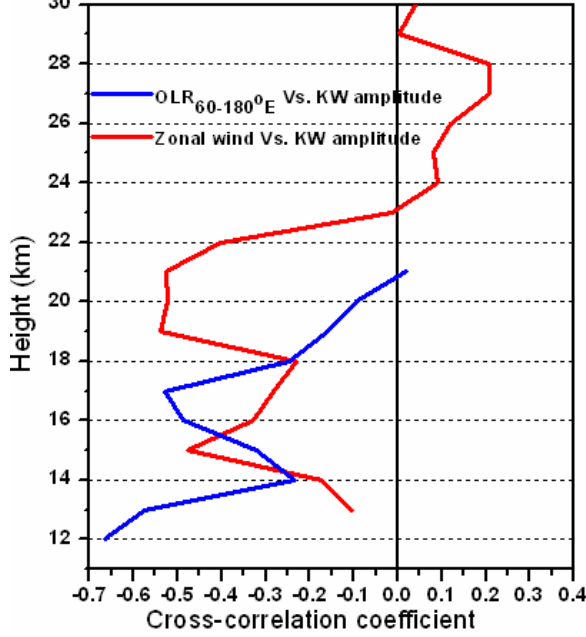
Figure 8. Cross correlation observed in between the amplitudes of Kelvin waves and Fig. 8. Cross correlation observed in between the amplitudes of background wind (red line) and OLR data from 60-180 o E longitude band (blue line) the Kelvin waves and the background wind (red line) and OLR data from 60–180 ◦ E longitude band (blue line) observed during observed during May 2001 to October 2005. May 2001 to October